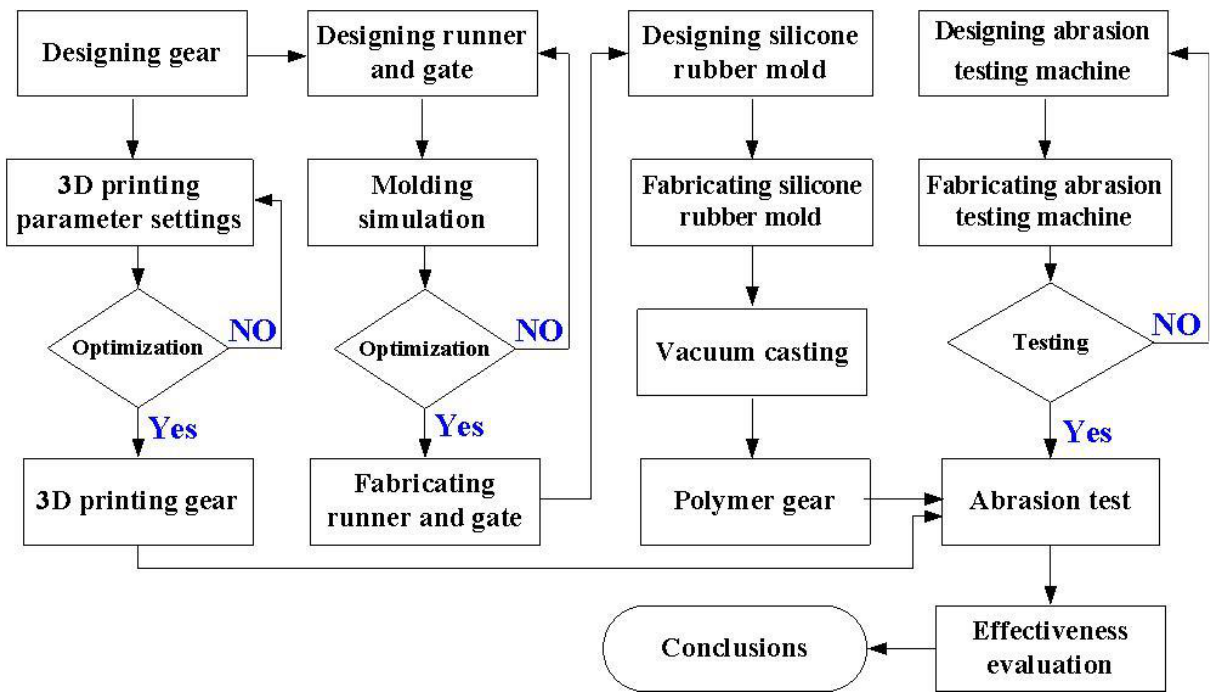
Figure 1. Research process of this study.